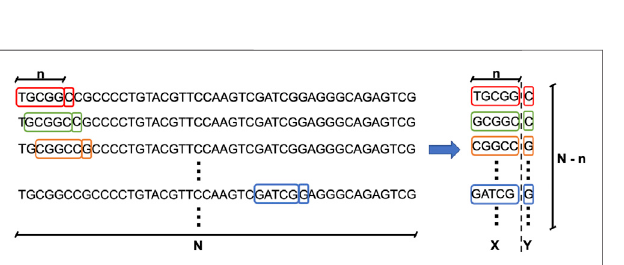
FIGURE 4 | Creation of training data for the generator model. The training data are composed of input – output sub-sequences, where a given inputsubsequenceoflength n willservetopredictoneoutputsymbol,whichis the next nucleotide in the sequence. Going through the whole genome sequence of a given phage oflength Nwill, thus, generate(N -n) input – output sub-sequences of length (n+1) symbols. The value n, called seed length, is de fi ned as the number of nucleotide symbols that needs to be passed to the generator model to predict the next